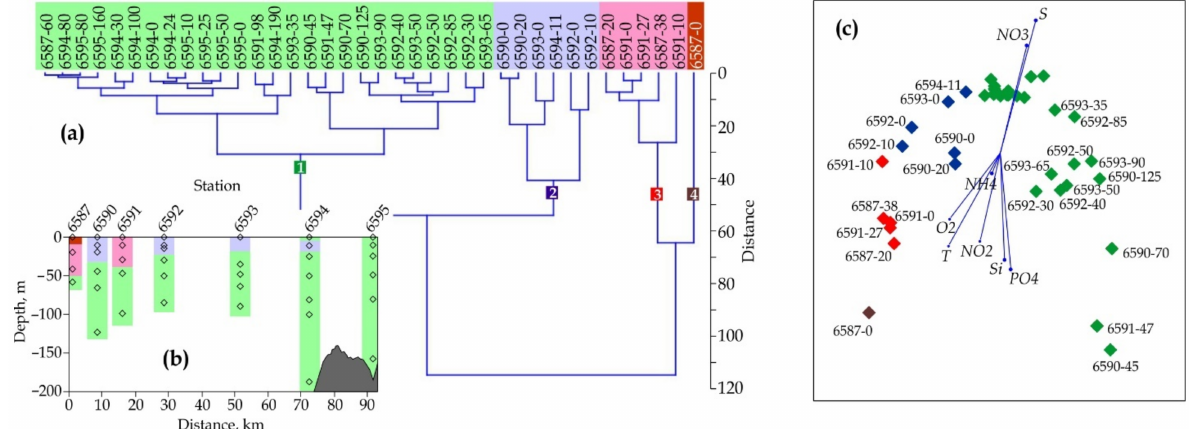
Figure 7. Cluster and non-metric multidimensional scaling (nMDS) analyses performed on the variables characterizing the nanophytoplankton community in the Bransfield Strait during austral summer, January 2020: ( a ) Dendrogram of a hierarchical cluster analysis with Euclidean distance measure, and four identified clusters; single samples are marked with a code indicating the station and depth of sampling; ( b ) Locations of nanophytoplankton assemblages identified by cluster analysis; background colors correspond to the cluster numbers in ( a ). ( c ) nMDS ordination of the nanophytoplankton samples with the environmental variables overlaid; symbol colors correspond to the cluster numbers in ( a ); single samples are marked with the code indicating the station number and the depth of